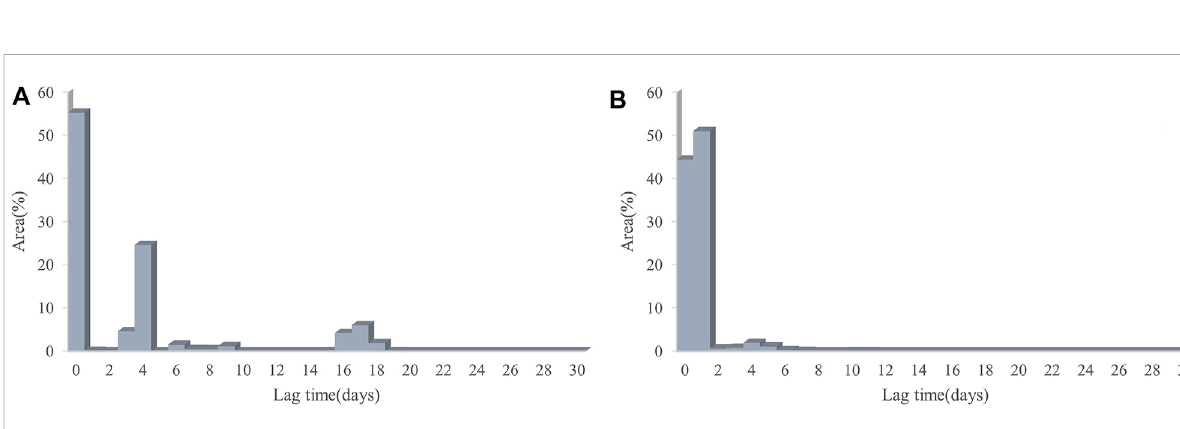
FIGURE 11 Proportion of NPP to precipitation (A) and temperature (B) with different lag times in the watershed area